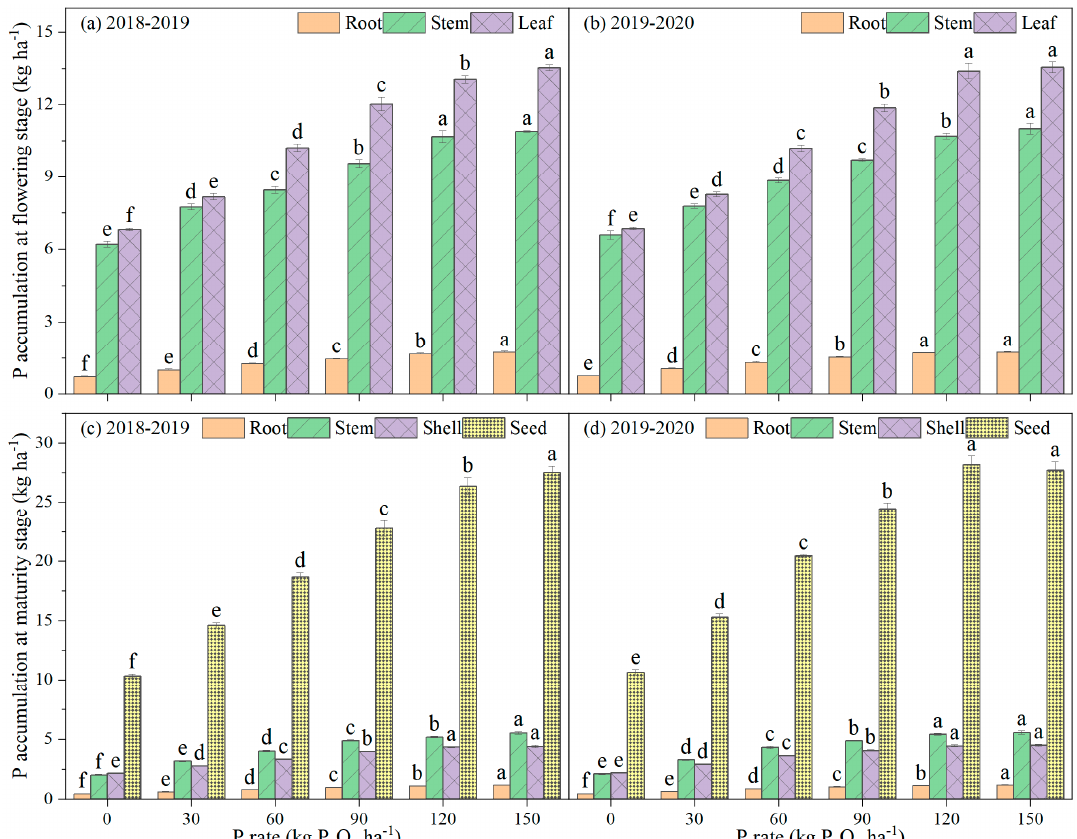
Figure 2. Effects of P rate on P accumulation of canola plants in a saline environment. ( a , b ): P accumulation at flowering stage during 2018–2019 and 2019–2020 growing seasons. ( c , d ): P accumulation at maturity stage during 2018–2019 and 2019–2020 growing seasons. Different letters indicate significant difference at p = 0.05 between P rate treatments for the same plant organ.